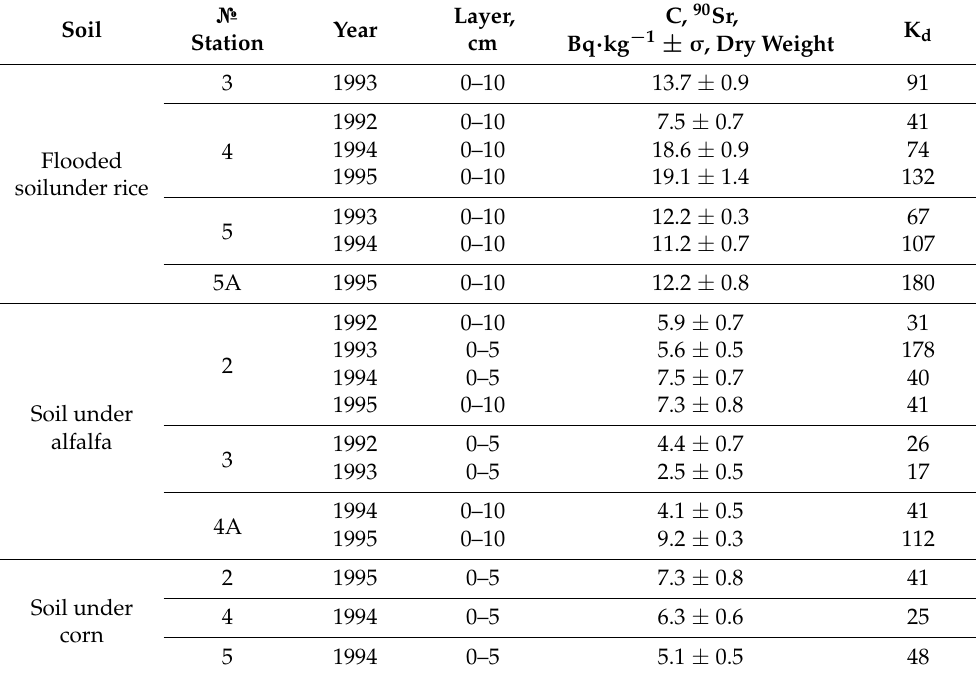
Table 2. Concentrations (C) and distribution coefficients (K d ) of 90 Sr in irrigated soils near the NCC area (1992–1995).